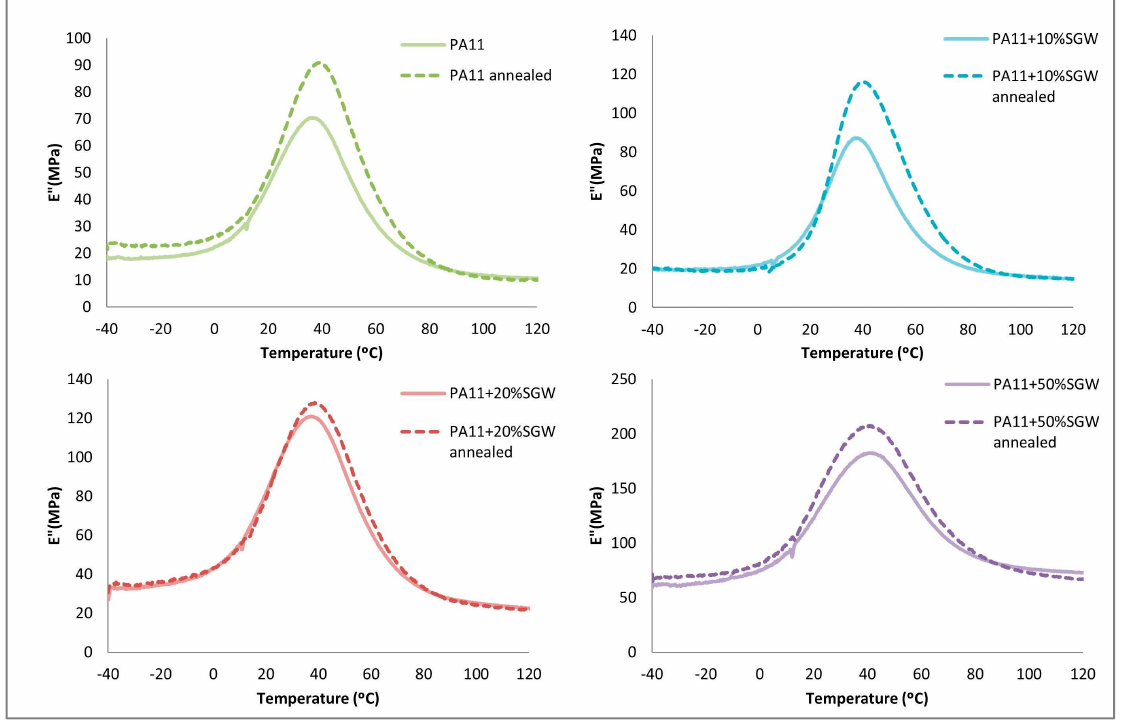
Figure 8. Loss modulus obtained by DMTA of the treated and untreated samples.